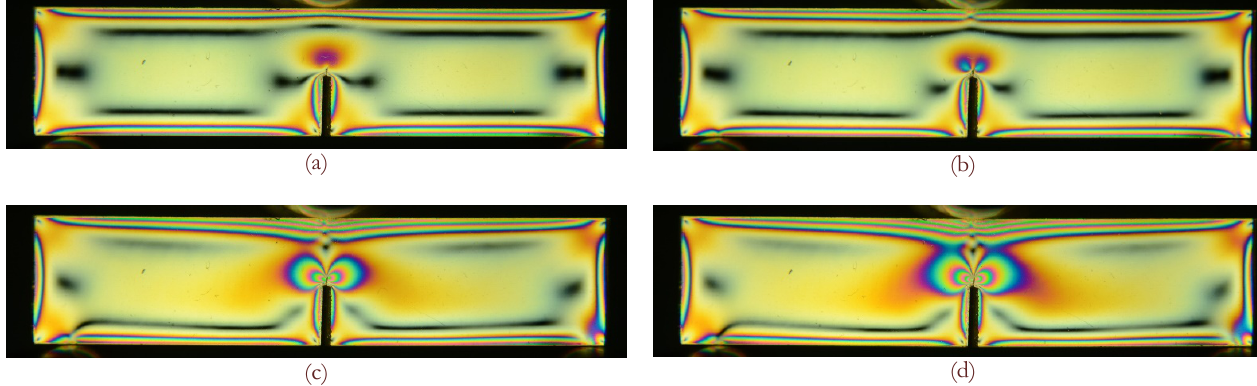
Figure 7: Isochromatic maps of SENB sample (circular dark field polariscope in white light) during the three point bending fracture test, at various applied loads: (a) 0 N; (b) 2 N; (c) 8 N; (d) 10